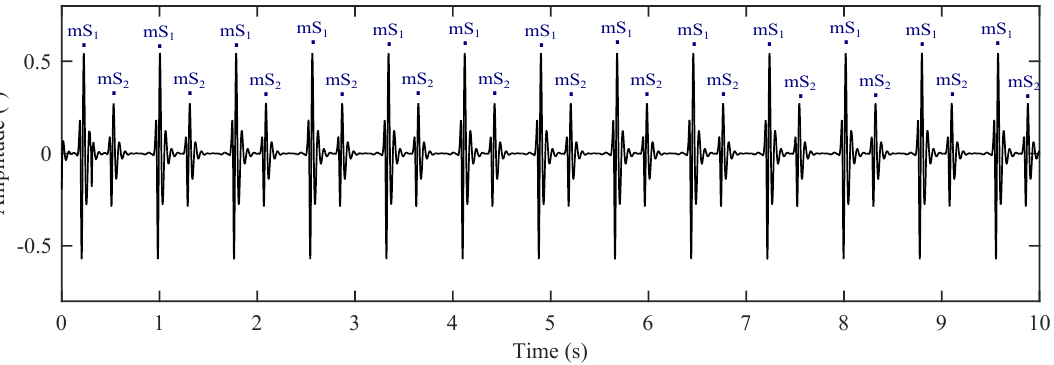
Figure 9. Recording of a reference signal for the adaptive system represented by IS T in the thoracic